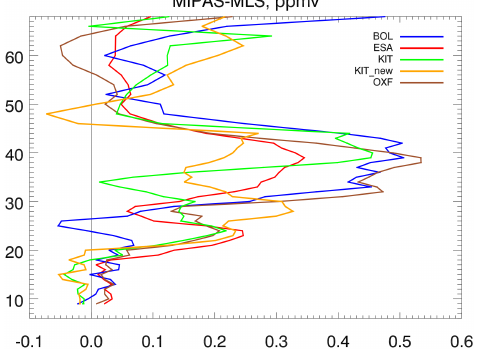
Figure 2. Bias assessment of four MIPAS processors with respect to MLS from Laeng et al. (2014) with bias of V5R_O3_224 over- plotted (orange curve).